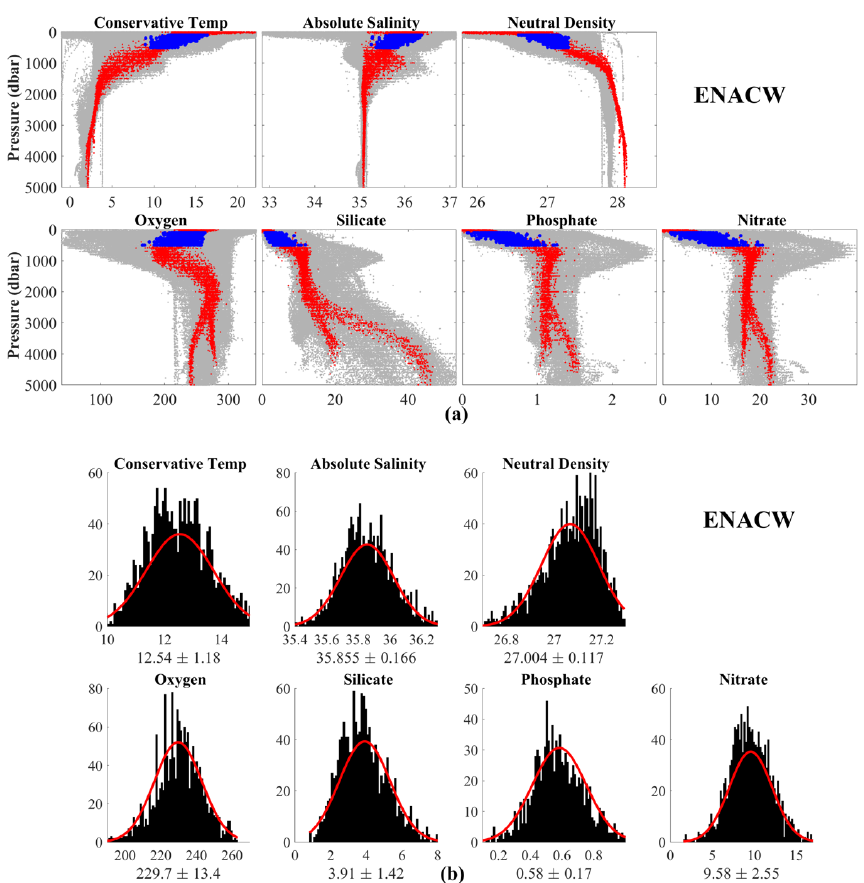
Figure 7. Example of the definition of an SWT (here ENACW): (a) the distribution of key properties vs. pressure; (b) bar plots of the data distribution of samples used to define the SWTs: conservative temperature ( ◦ C), absolute salinity (gkg − 1 ), neutral density (kgm − 3 ), oxygen and nutrients (µmolkg − 1 ). The red Gaussian fit shows mean value and standard deviation of selected data.